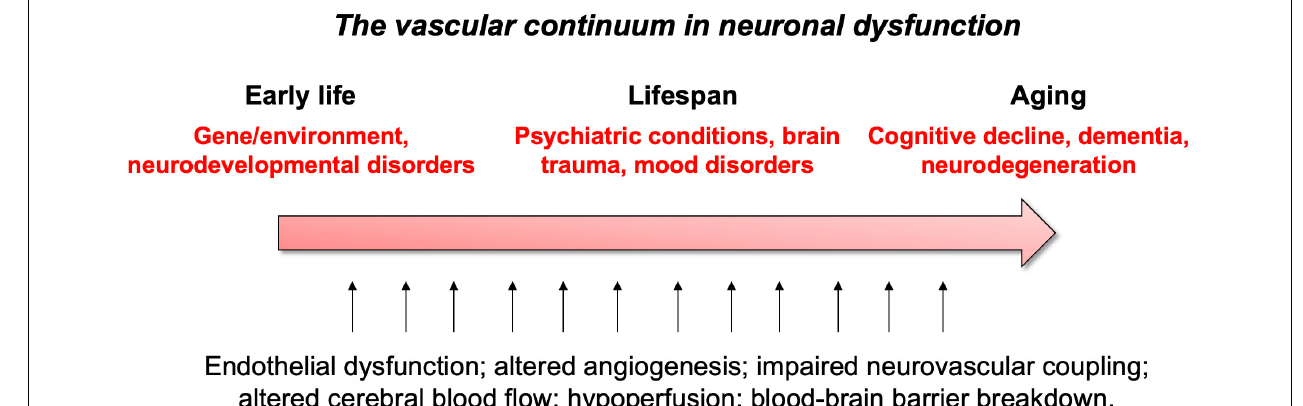
FIGURE 3 | Summary of vascular links to neurological disease throughout